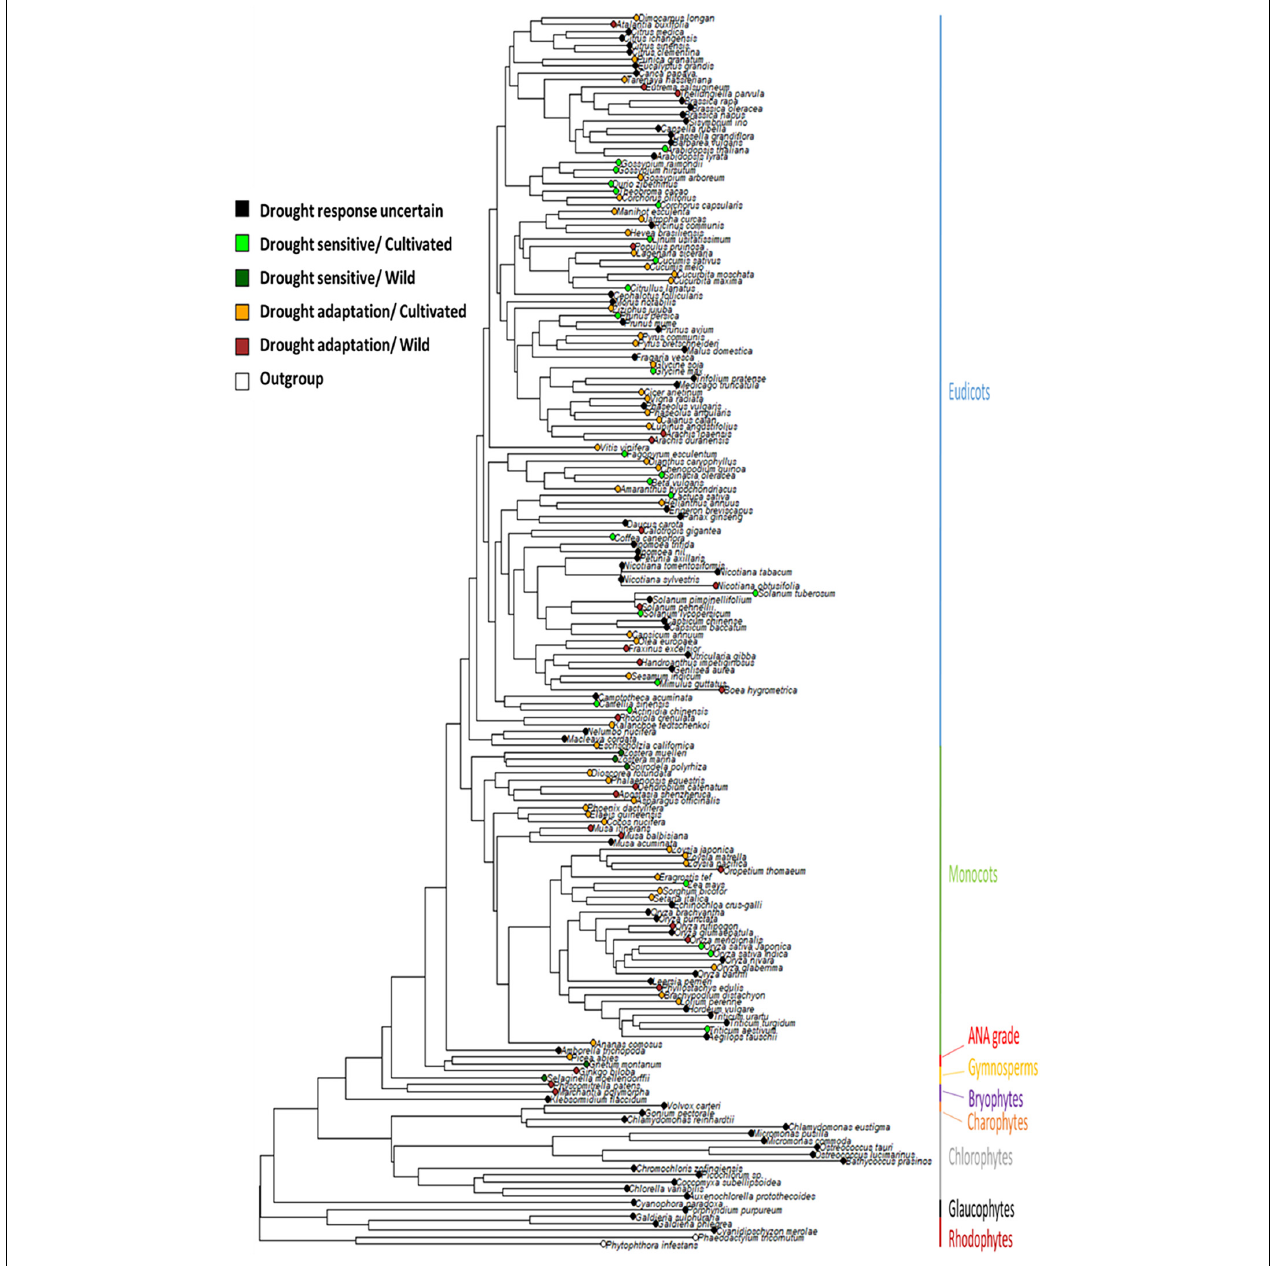
FIGURE 2 | Distribution of drought adaptation and domestication on a species tree. Terminal nodes indicate the status of each species drought adaptation combined with their domestication